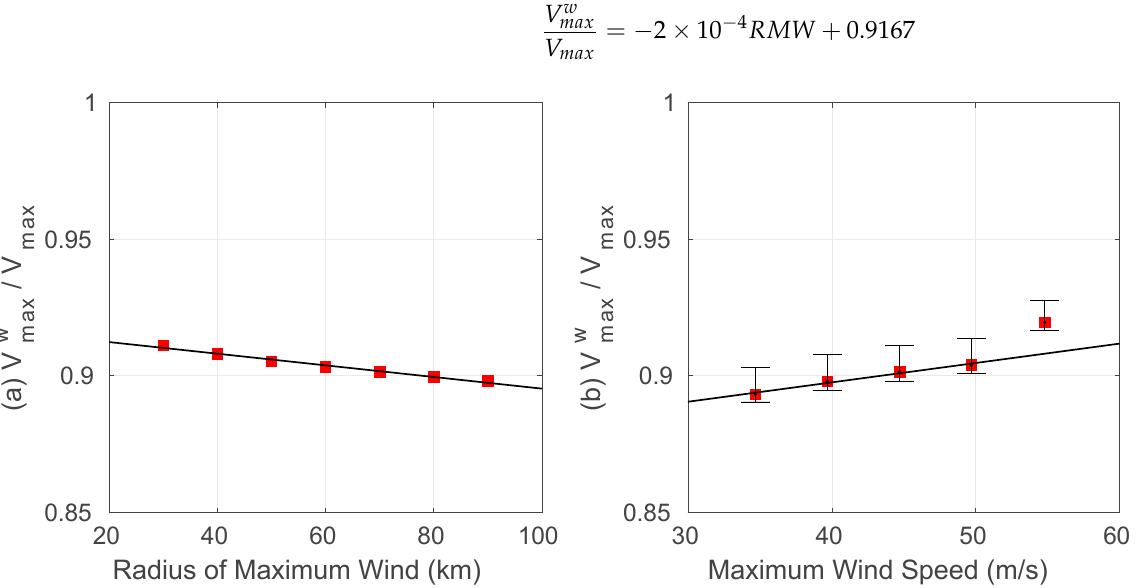
Figure 2. The ratio of V w max to V max ( a ) at different radius of maximum wind (red square) in experiment A, and ( b ) at different maximum wind speed and radius of maximum wind speed in experiment B with the red squares representing the ratios for TCs with a radius of maximum wind of 70 km. The upper and lower limits of the error bar in ( b ) indicate the ratio values for TCs with a radius of maximum wind of 90 and 30 km, respectively. In both figures, the black lines give the linear regression of the ratios.